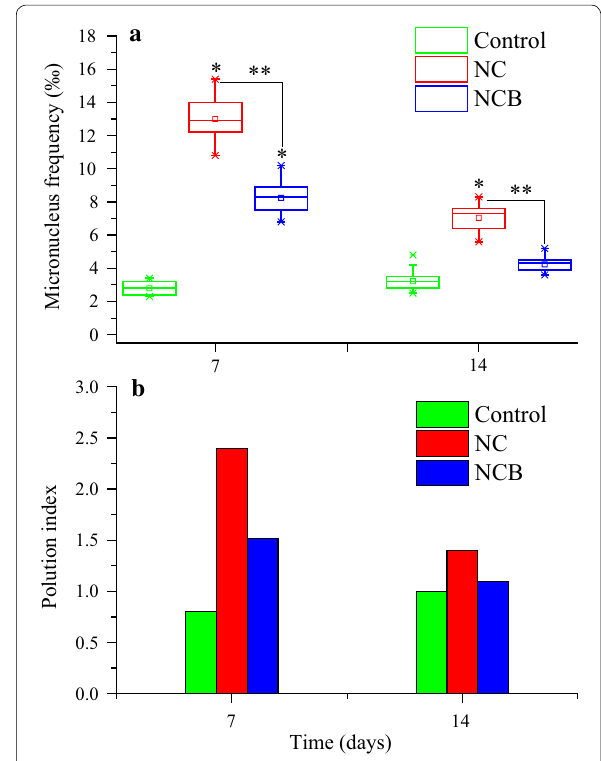
Fig. 4 Micronucleus frequency ( a ) and pollution index ( b ) of Vicia faba treated with different soil solutions. Asterisk (*) indicates statistical significance of treatments in comparison to the control at p < 0.05. Two asterisks (**) indicates statistical significance between NC and NCB at p <